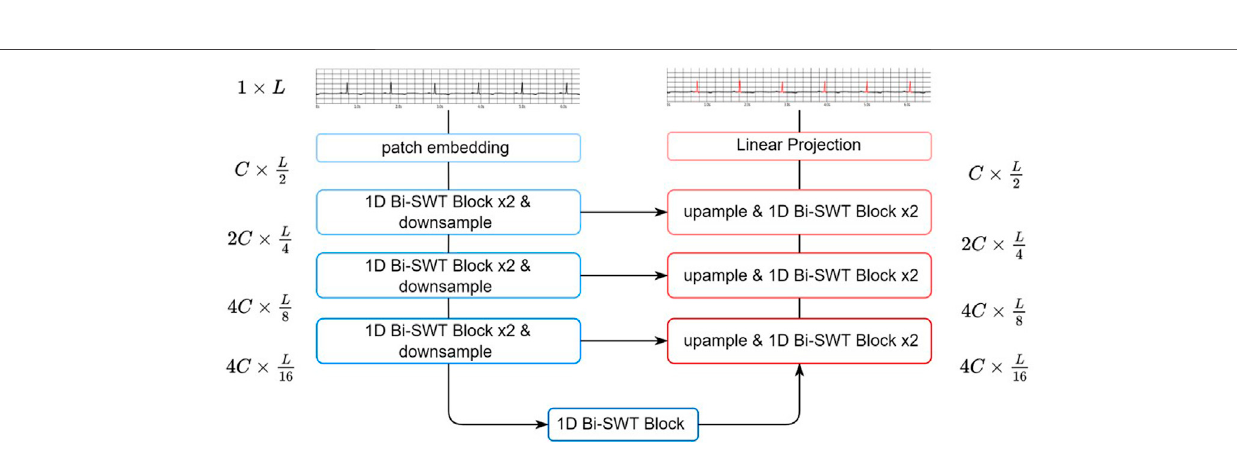
FIGURE 2 | The architecture of the